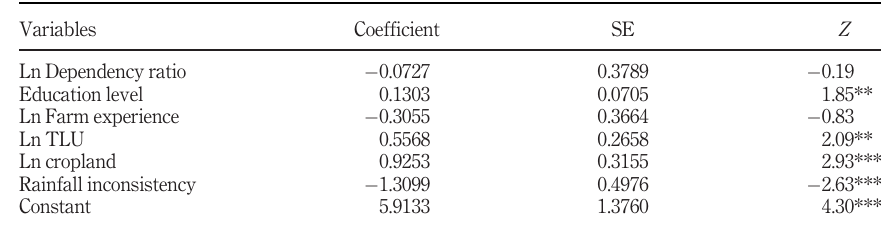
Table V. Determinants of households ’ crop